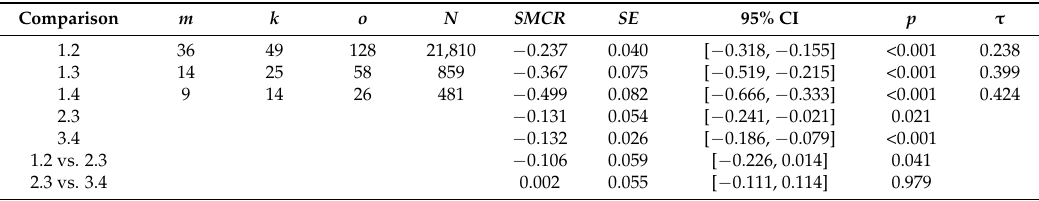
Table 2. Meta-Analytically Derived Effect Sizes for RT Reduction due to Retesting.